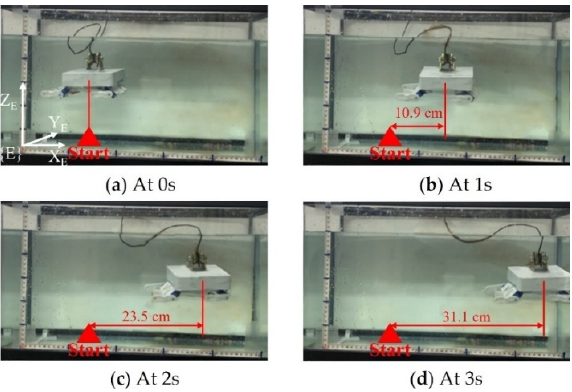
Figure 20. Experiments on forwarding motion in a swimming motion.